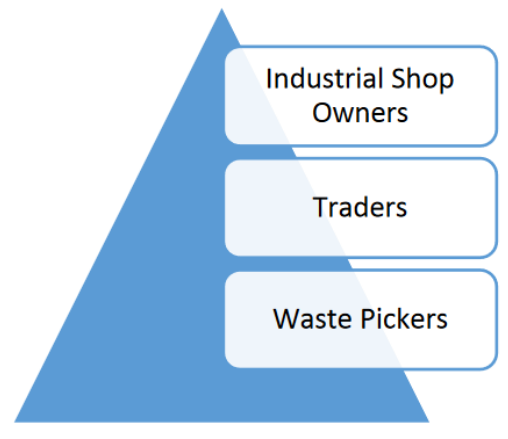
Figure 4: The structure of the informal sector in developing countries by CWG-GIZ